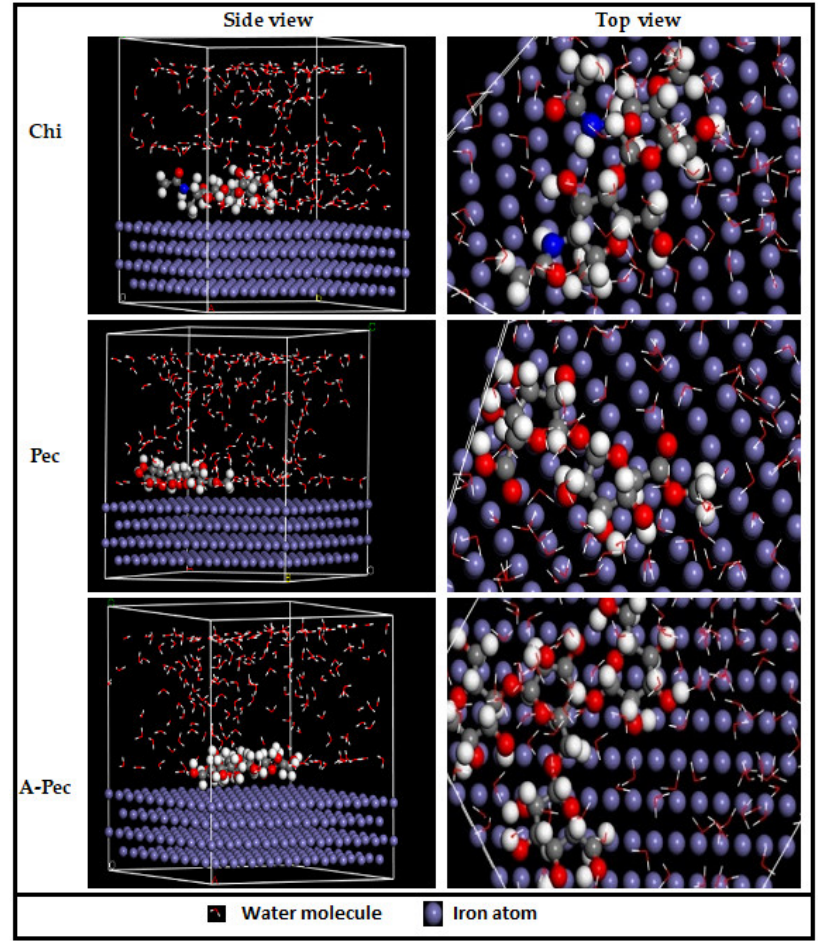
Figure 21. Equilibrium adsorption configurations of the studied carbohydrate polymer molecules on the Fe (110) surface obtained with molecular dynamic simulations.